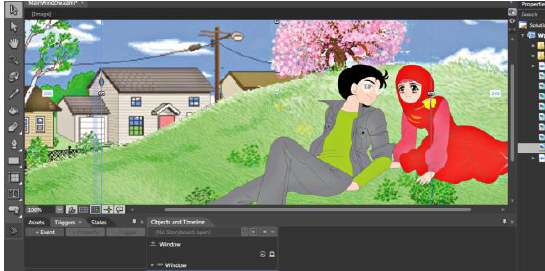
Figure VII. Choosing and animating new